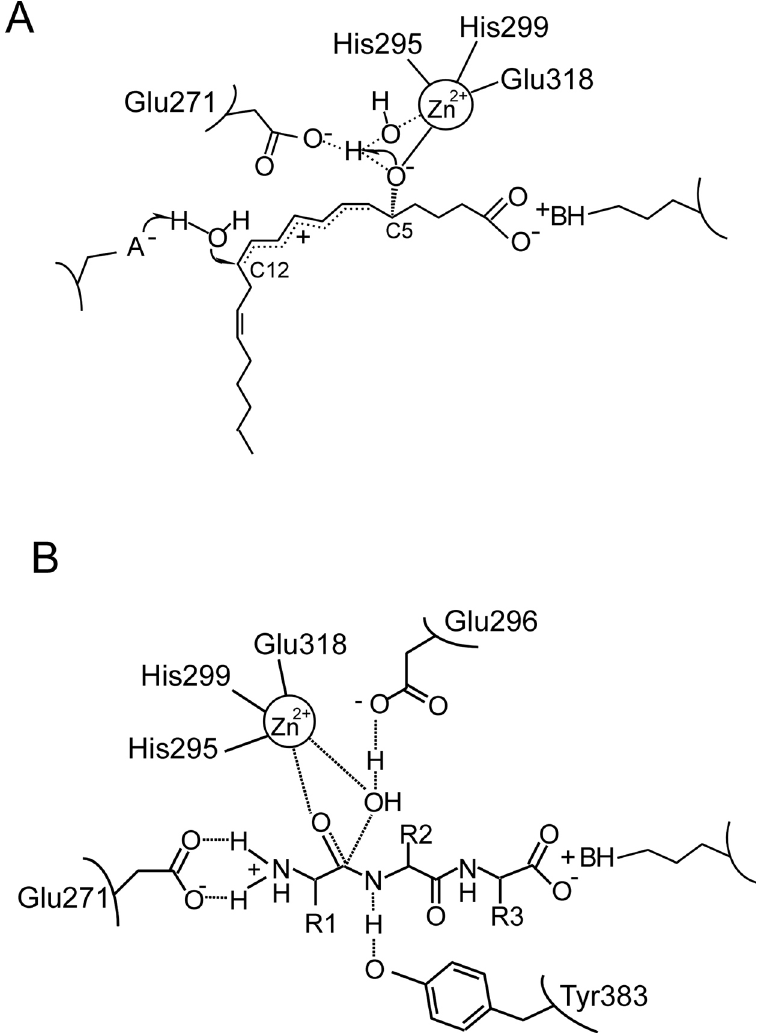
FIGURE 6. Putative mechanisms for the epoxide hydrolase and aminopeptidase reactions. (A) In hydrolysis of LTA 4 , the catalytic zinc, assisted by the carboxylate of Glu-271, polarizes a water molecule to promote an acid induced activation of the epoxide. As a result, the oxirane ring opens up to form a carbocation intermediate according to an S N 1 reaction. Water is added at C12 in a stereospecific manner, presumably directed by a polar residue depicted as A - in the figure. A basic residue, indicated by BH + , probably acts as a carboxylate recognition site. (B) In the aminopeptidase reaction, an activated water molecule bound to the zinc is displaced by a carbonyl group of the incoming tripeptide substrate. The α -aminogroup of the substrate gets attached to Glu-271, acting as an N- terminal recognition site. The water is polarized by the base, Glu-296, and attacks the peptide bond. Simultaneously, a proton is donated from Tyr-383. information regarding the function of Tyr-378 and Tyr-383. Thus, both residues are hydrogen- binding they get in close contact with the bonded to each other and in our model of LTA 4 conjugated triene system just at the angle of the L-shaped binding cavity. In fact, their positions would become ideal for assisting optimal substrate alignment and promoting a specific double bond configuration, in line with what has been proposed from mutational analysis and catalytic hydrolases[27,36,48]. Clearly, further studies are properties of [Y378F]- and [Y383Q]LTA 4 required to elucidate and corroborate this model for the mechanism of enzymatic conversion of LTA into LTB . In particular, the role of the hydrophobic, L-shaped cavity for binding of LTA 4 4 4 needs to be